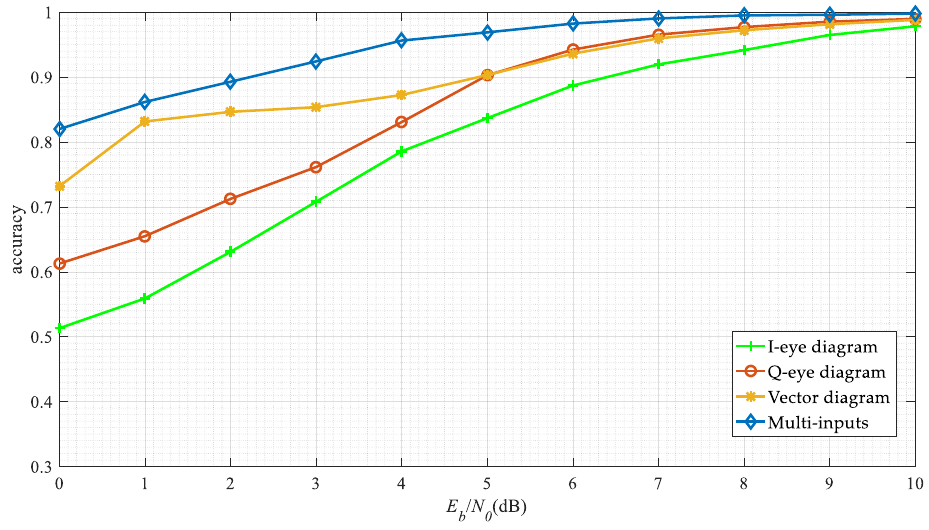
Figure 17. The network performance on the different input model.